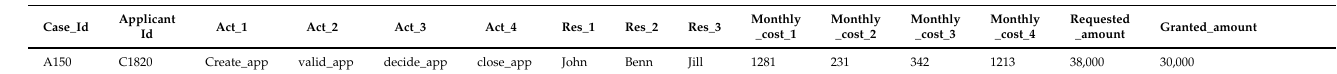
Table 3. Feature vector created for case with id = A150 from the log in Table 1 using index-based